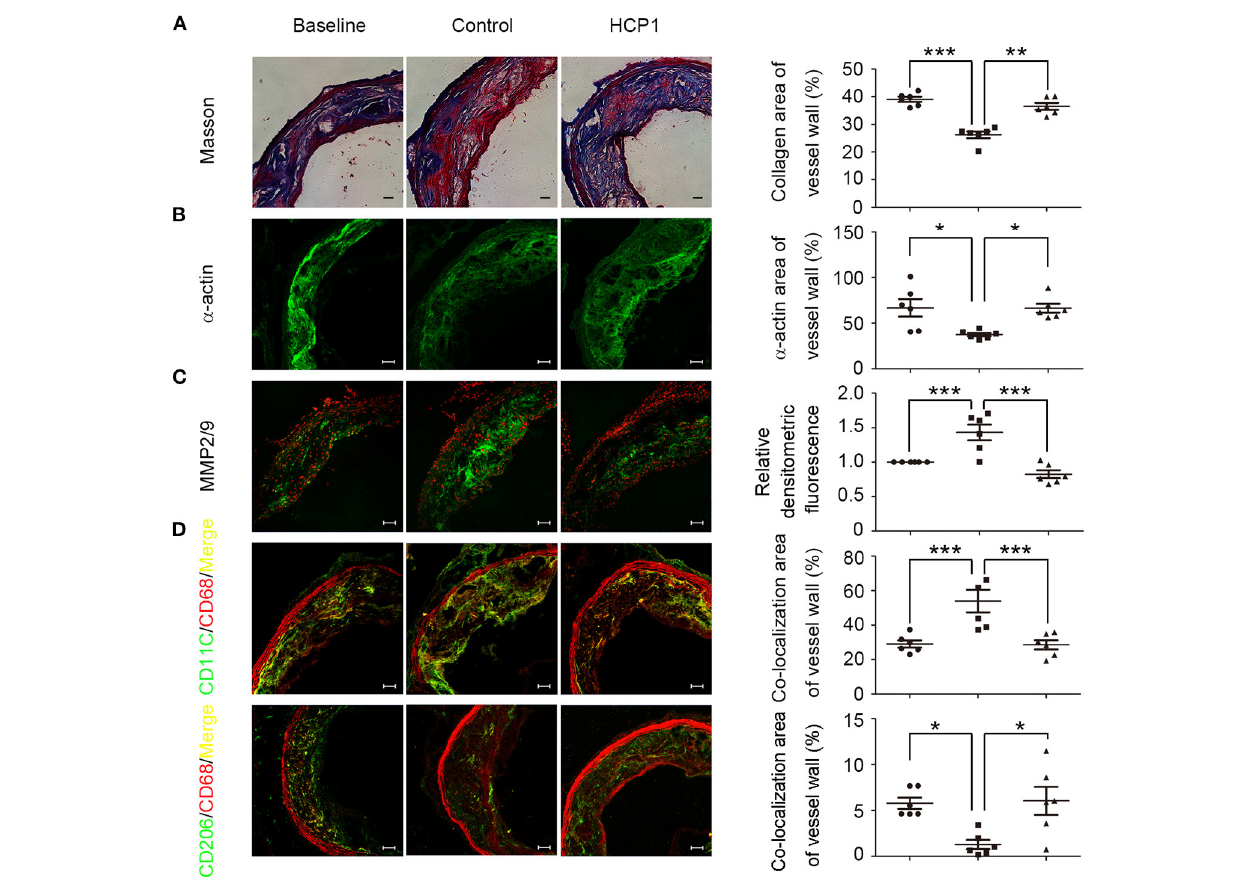
FIGURE 7 | HCP1 improved aortic atherosclerotic plaque stabilization in apoE − / − mice. From the top to the bottom panel, masson trichrome staining of collagen (in blue) (A) , immunostaining for mouse α -smooth muscle actin (B) , in situ zymography detecting MMP-2/9 activity (C) , double-stained images of co-localization (yellow) of CD11C (green) and CD68 (red) -positive areas (D) and double-stained images of co-localization (yellow) of CD206 (green), and CD68 (red) -positive areas (D) . Scale bars, 50 µ m. Bar charts show quantification of collagen, α -actin area in the atherosclerotic lesion, MMP-2/9 activity, weighted colocalization coefficients for CD11C and CD206 positive areas in baseline, control, and HCP1-treated groups. Data are mean ± SEM; * p < 0.05, ** p < 0.01, *** p < 0.001; n = 6. Statistical analyses were performed using one-way